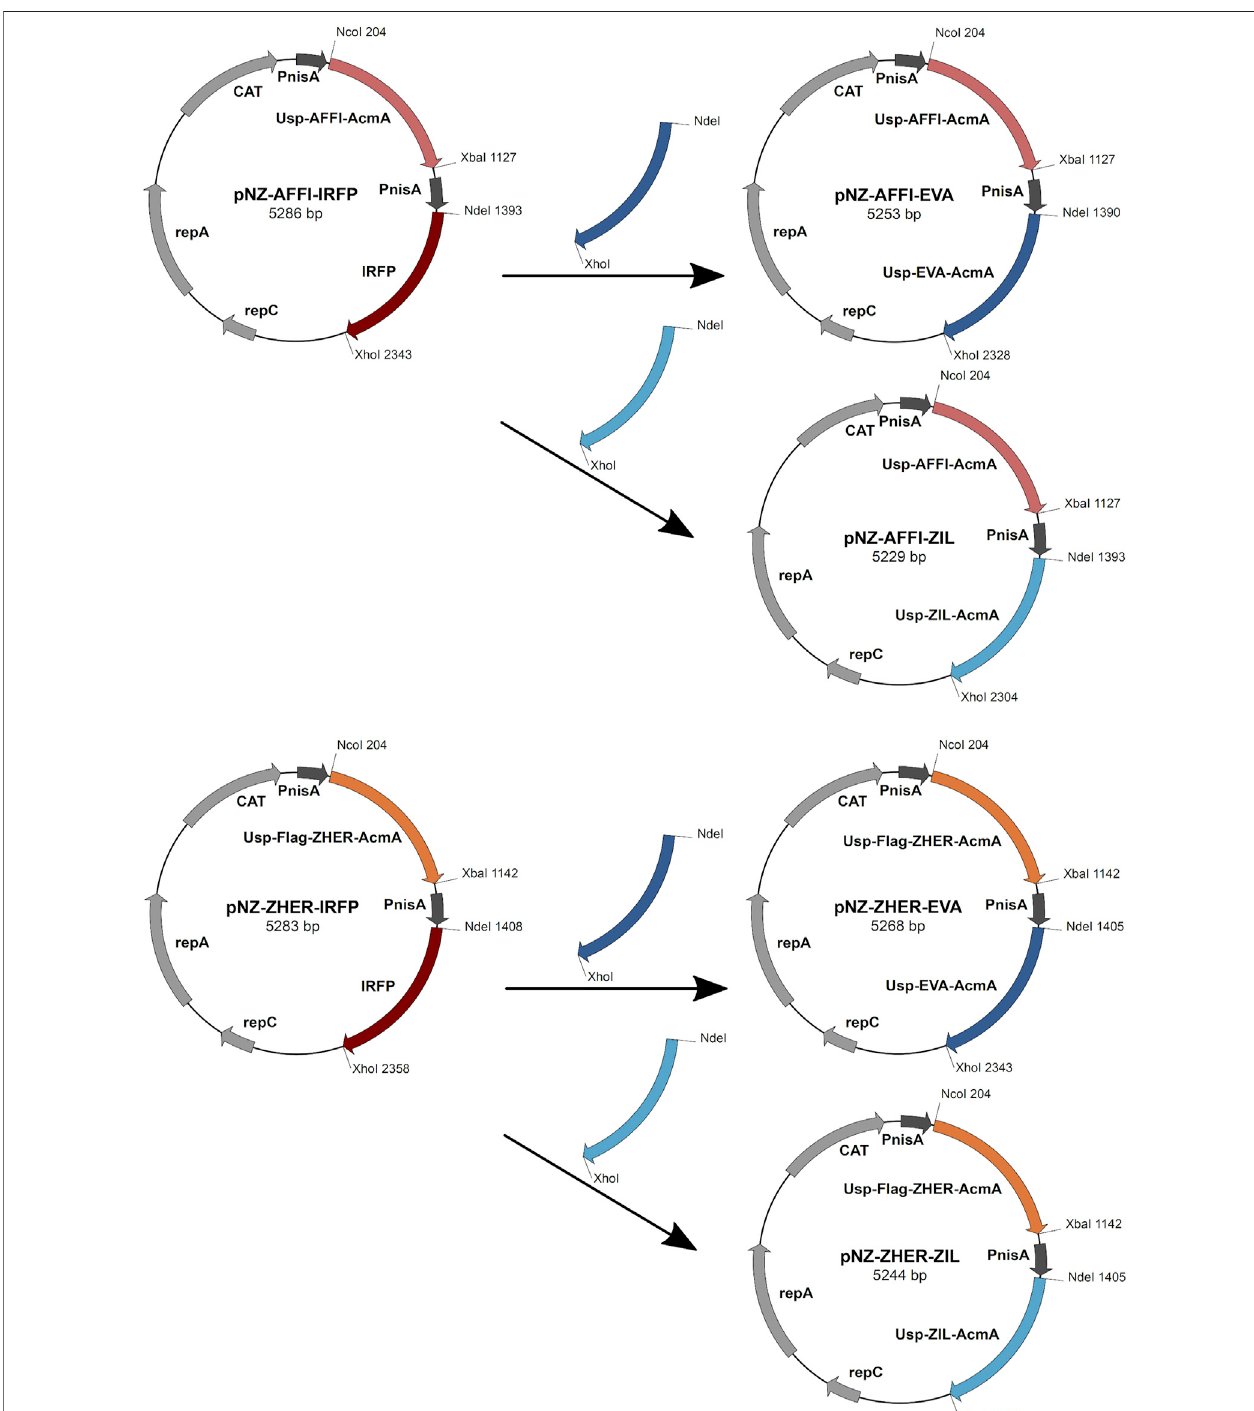
FIGURE 1 | The scheme of the construction of dual expression plasmids. For construction of dual plasmids for surface display of tumor antigen binders and cytokinebinders,weusedpreviouslypreparedpNZDualplasmidswhichalreadycontainedexpressioncassettewiththetumorantigenbindergene(ZHERorAFFI)inmultiple cloningsite1andIRFPinmultiplecloningsite2.IRFPwassubstitutedbytheexpressioncassettecontainingthecytokinebindergene(EVAorZIL).Thus,tumorantigenbinder waspairedwithacytokinebinder,resultinginfourdualplasmidspNZ-AFFI-EVA,pNZ-AFFI-ZIL,pNZ-ZHER-EVA,andpNZ-ZHER-ZIL.Ineachexpressioncassette,the bindergene wasfused withthegene for Usp45secretion signaland the genefor peptidoglycan bindingdomain ofthe AcmAprotein,toenablesurfacedisplay ofthe binder following its expression. AFFI, gene encoding EpCAM-binding af fi tin (183 bp); ZHER, gene encoding HER2-binding af fi body (174 bp); EVA, gene encoding IL-8-binding evasin-3 (243 bp); ZIL, gene encoding IL-6-binding af fi body (174 bp); Usp, gene encoding Usp45 secretion signal peptide (84 bp); AcmA, gene encoding the C-terminal portion of the AcmA surface anchoring protein containing three LysM repeats (642 bp); FLAG, epitope tag sequence; PnisA, nisin promoter.